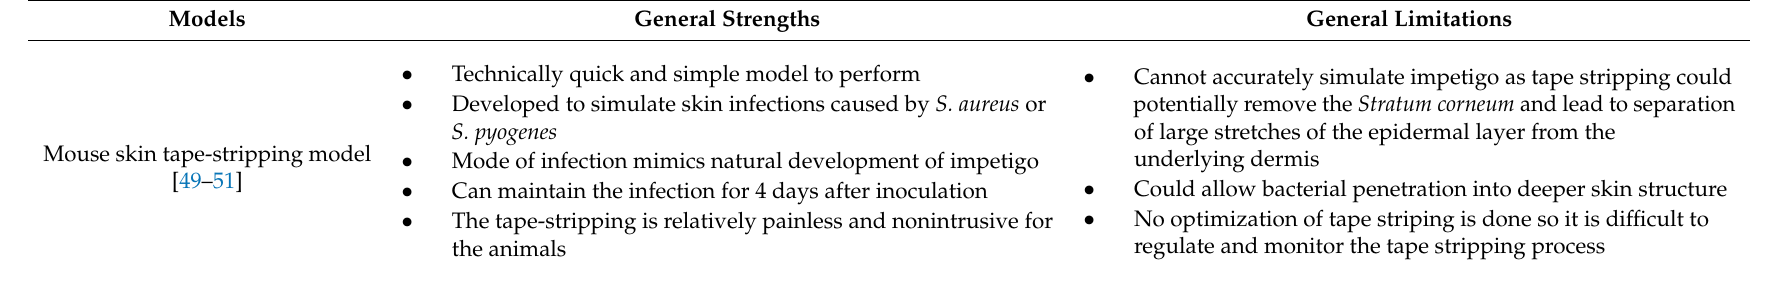
Table 2. A summary of the strengths and limitations of the rodent models investigated for